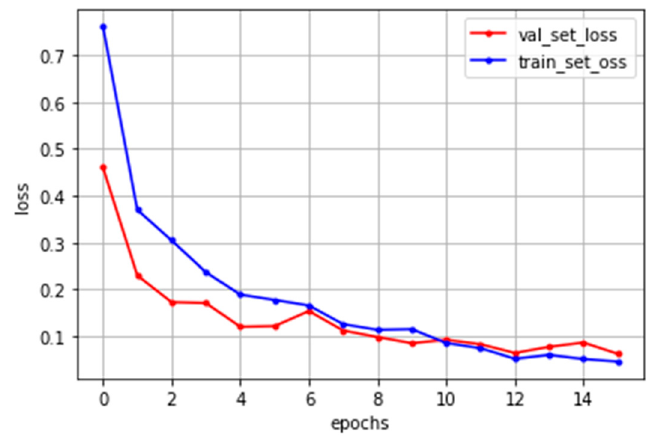
Figure 7. Nonlinear defect CNN model training result.